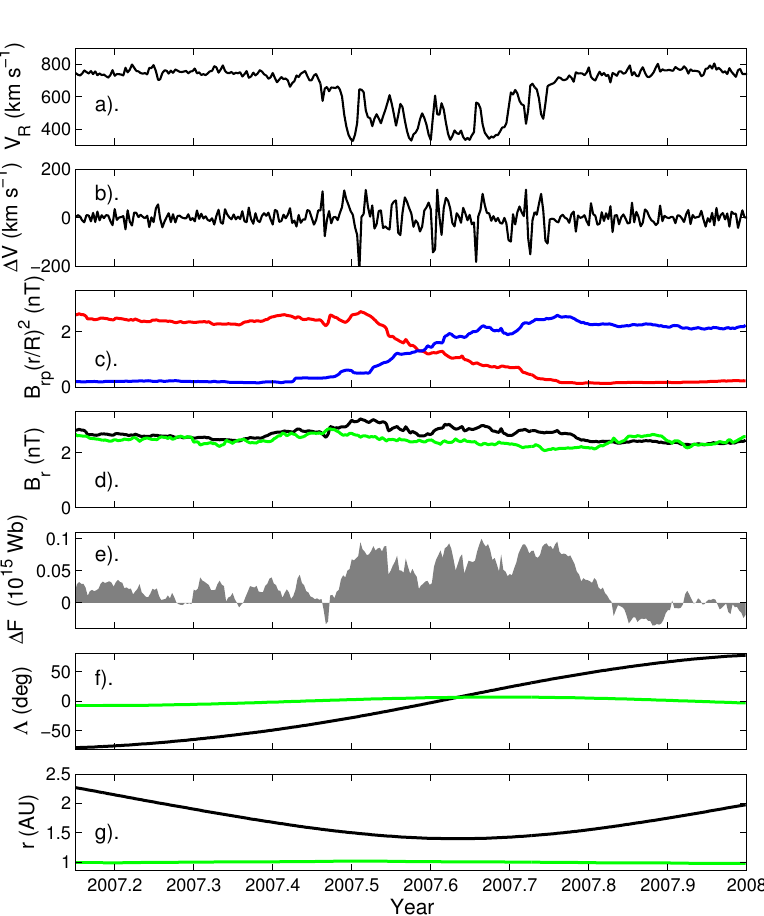
Figure 17: A comparison of Ulysses and ACE data during the third perihelion pass of Ulysses, which took place between day 36 of 2007 and day 13 of 2008. In all panels, black lines are data from Ulysses while green lines are from ACE, which is in a halo orbit around the L1 Lagrange point. From top to bottom: (a) daily means of the solar wind speed, 𝑉 SW ; (b) The difference between successive daily 𝑉 SW values, Δ 𝑉 ; (c) The 27-day running means of the away and toward (red and blue lines, respectively) radial field components 𝐵 𝑟𝑝 observed at Ulysses and averaged separately; (d) 27-day running means of the normalized absolute radial field magnitude at Ulysses, ( 𝑟 𝑈 /𝑟 1 ) 2 ⟨| 𝐵 𝑟𝑈 | 𝑇 ⟩ 27d (black line), and ACE, ⟨| 𝐵 𝑟𝐴 | 𝑇 ⟩ 27d (green line); (e) The flux excess at Ulysses, defined as Δ 𝐹 = 2 𝜋 × [ 𝑟 2 ⟨| 𝐵 𝑟𝑈 | 𝑇 ⟩− 𝑟 2 ⟨| 𝐵 𝑟𝐴 | 𝑇 ⟩ 27d ] (grey shaded area); 1 𝑈 (f) The heliographic latitude of Ulysses (Λ 𝑈 , black line) and ACE (Λ 𝐴 , green line); (g) The heliocentric distance of Ulysses ( 𝑟 𝑈 , black line) and ACE ( 𝑟 𝐴 = 𝑟 1 , green line). In all cases the radial field values are the asymptotic values for the averaging timescale T approaching zero. Image reproduced by permission from Lockwood et al. (2009b), copyright by